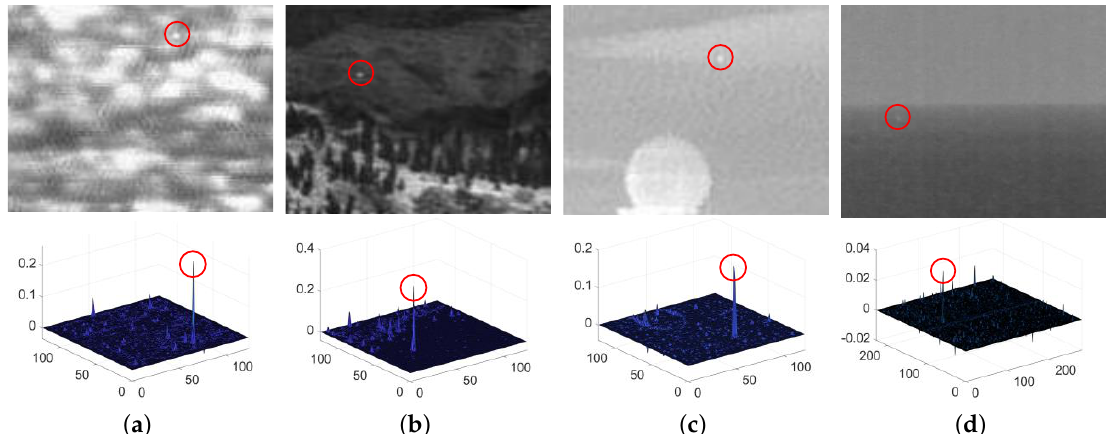
Figure 2. Some seeds selection map (SSM) examples of the representative infrared images with small targets in ( a ) the sunlit lake, ( b ) the country road, ( c ) the twilight sky and ( d ) the sea-sky background. The first row contains four input images with small targets embedded in complicated backgrounds and heavy noise. The second row consists of the corresponding SSM. The red circles indicate the ground-true